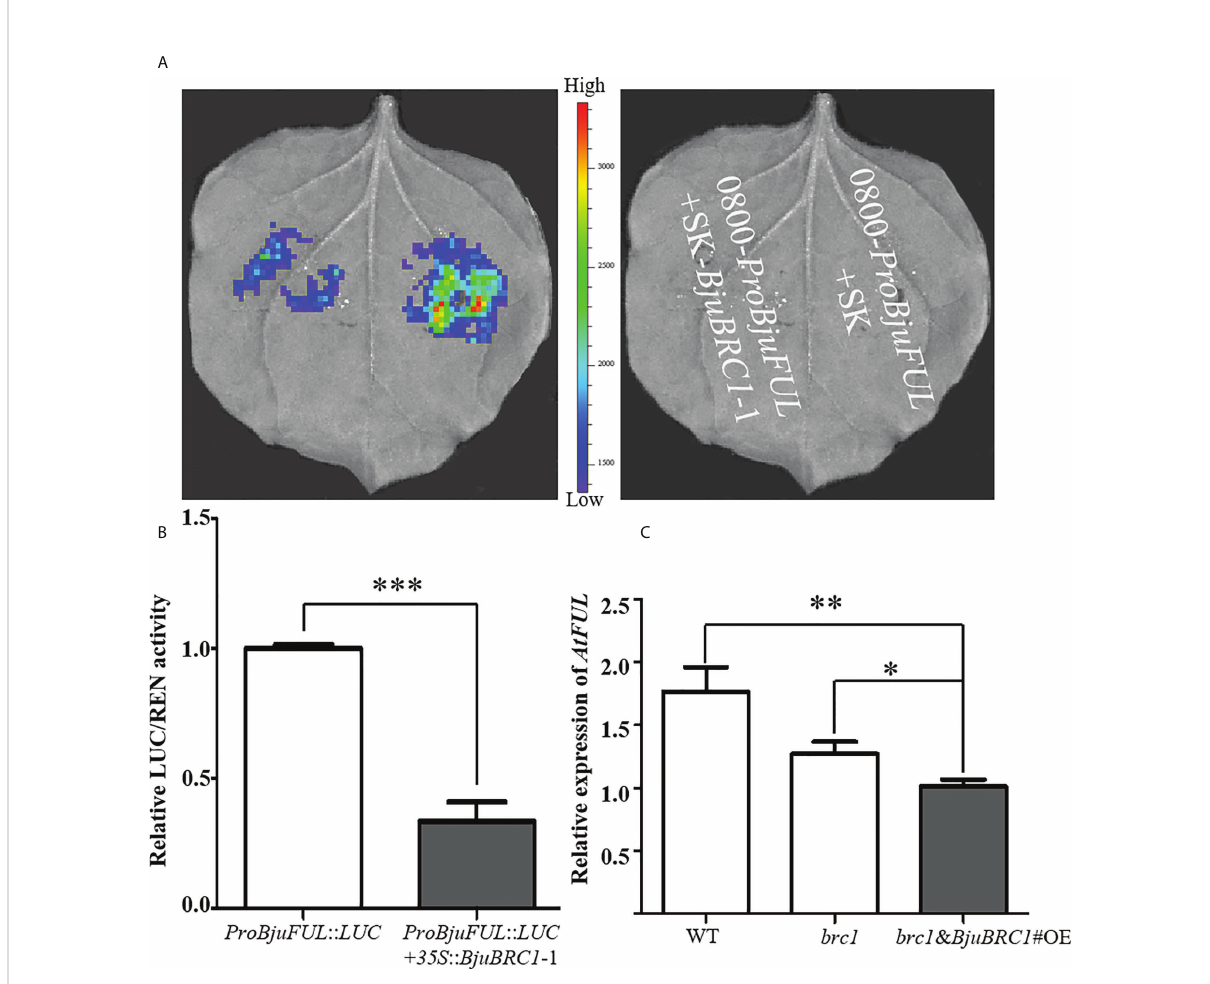
FIGURE 7 BjuBRC1-1 regulates the expression of BjuFUL . (A) LUC assays to detect the activation/repression function of BjuBRC1-1 protein to ProBjuFUL (B) Dual-luciferase reporter assay to verify whether BjuBRC1-1 protein regulates the transcription of BjuFUL. (C) Relative expression levels of AtFUL in transgenic Arabidopsis compared with WT or brc1 mutant. Error bars represent SE. “ *** ” indicates signi fi cant difference, p < 0.001; “ ** ” , p < 0.01; “ * ” , p < 0.05. By Student ’ s